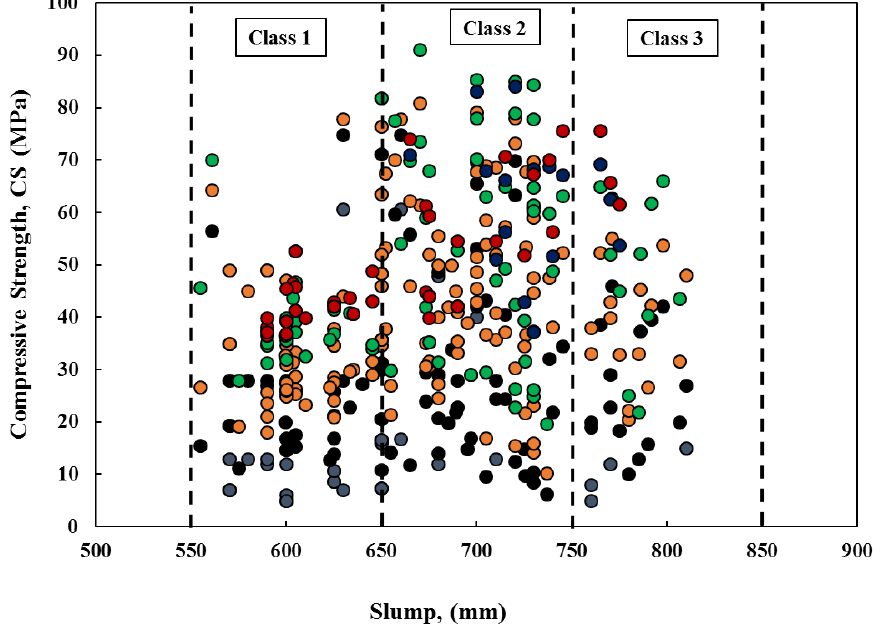
Figure 7. The relationship between the SCC mixture’s compressive strength and slump flow diam- eter.